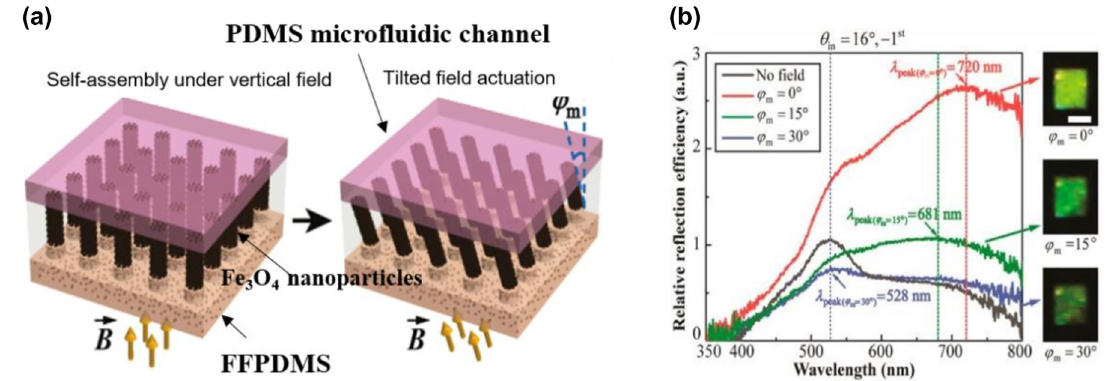
Figure 34: Dynamic structural color generation based on nanostructure geometric configuration modulation through external magnetic field. (a) Schematic illustration of the magnetic field responsive device, which is composed of an FFPDMS template, Fe microfluidic channel. Under an external magnetic field, the FFPDMS template generates a periodic local field to guide the Fe periodic self-assembled columns (SACs). The generated local field also has an “anchor effect” and will immobilize the base of SACs, allowing them to be tilted about the base to induce color change. (b) Measured reflection spectra of a fabricated sample’s -1st order reflection diffraction as well as the associated color appearance under an oblique illumination ( 𝜃 Modified with permission [337]. Copyright 2019, American Chemical